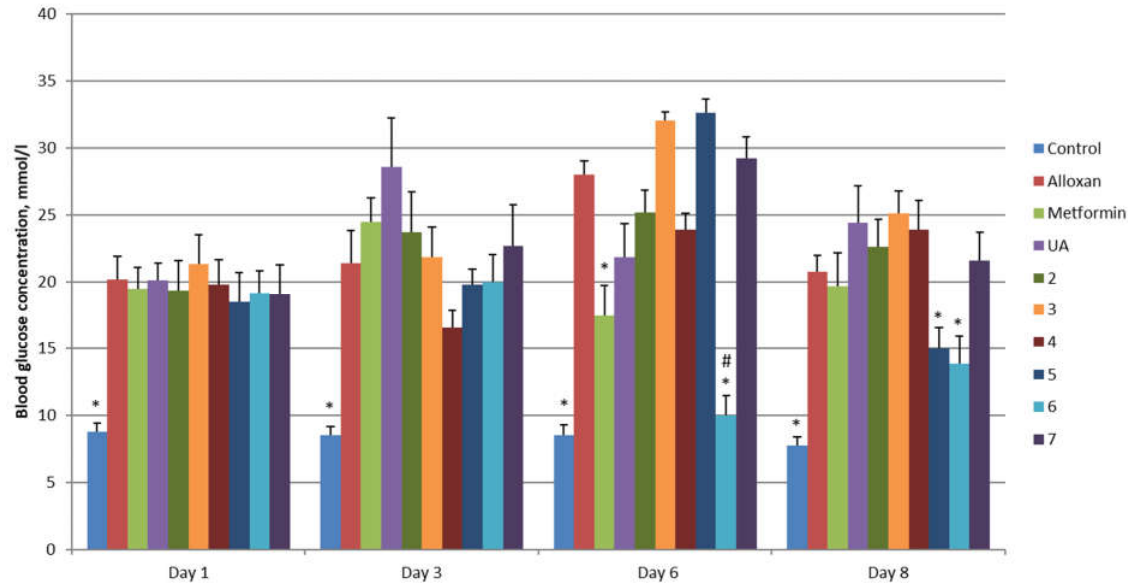
Figure 1. The effect of compounds 2 – 7 on the blood glucose level of mice with diabetes mellitus induced by alloxan. * p < 0.05 compared to the “Alloxan” group, # p < 0.05 compared to the “Metformin” group.